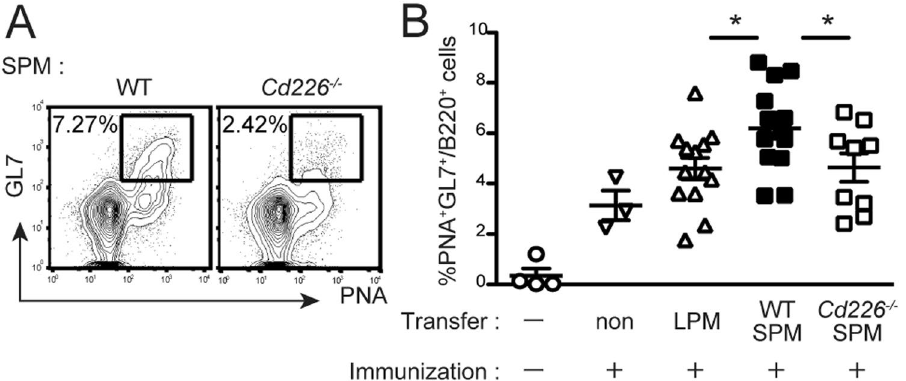
Figure 5. DNAM-1 on SPMs contributes to the GC reaction in mediastinal lymph nodes after immunization. ( A , B ) LPMs and SPMs were isolated from WT or Cd226 − / − donors, and 4 × 10 4 cells were transferred i.p. into Cd226 − / − recipient mice. At the same time, the recipient mice were immunized i.p. with TNP–OVA in alum adjuvant. Seven days after immunization, mediastinal lymph nodes were collected; the cells were stained with GL7 mAb, PNA, and anti-B220 mAb, and the frequencies of GC B cells (defined as the percentages of GL- 7 + PNA + cells in B220 + B cells) were determined by flow cytometry. Representative plots of staining (B220 + gate) from SPM-transferred mice ( A ). The scatter plot shows data combined from four independent experiments ( B ) error bars indicate SEM. * P < 0.05. One outlier was omitted from Cd226 − / −